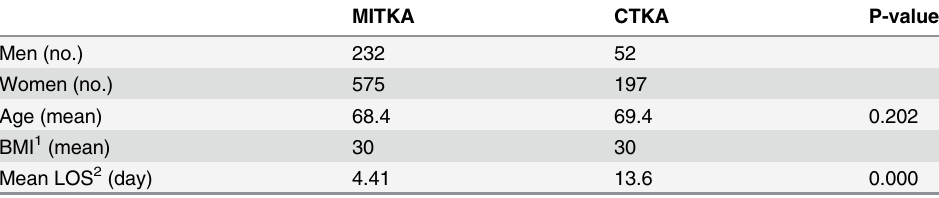
Table 1. Demographic and clinical features of MITKA and CTKA patients. MITKA CTKA P-value Men (no.) 232 52